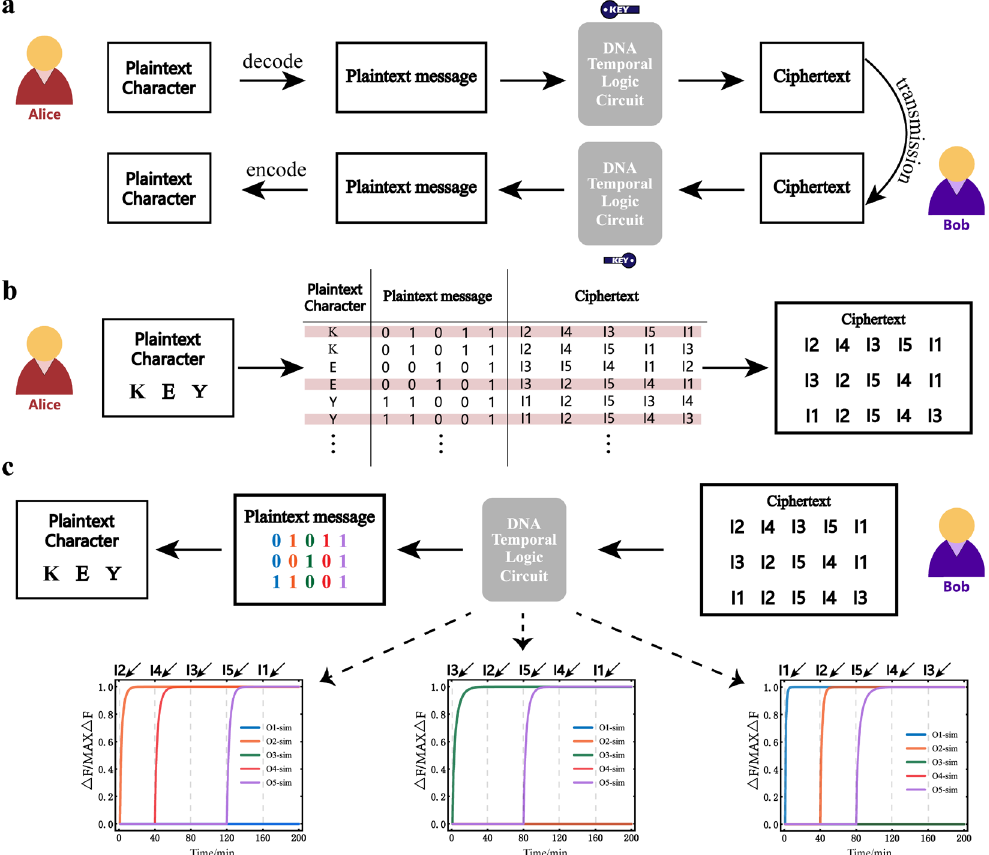
Figure 5. Application to the symmetrically encrypted communication of binary messages. ( a ) The information communication process between Alice and Bob. DNA temporal logic circuits are used as the key for symmetric encryption. ( b ) Alice encrypts the plain text into the cipher text according to the cipher book (the mapping table of the DNA temporal logic circuit). Alice has a variety of encryption options. She chose only the three cases in the red line. ( c ) The process of Bob’s decryption.